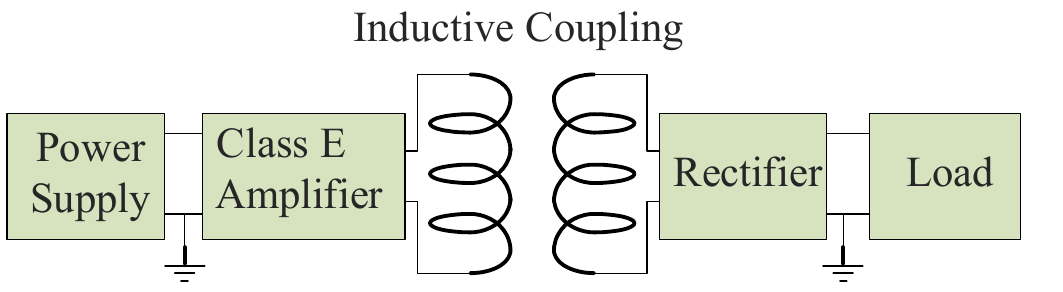
Figure 1. Schematic of the inductive coupling WPT with class ‐ E amplifier.